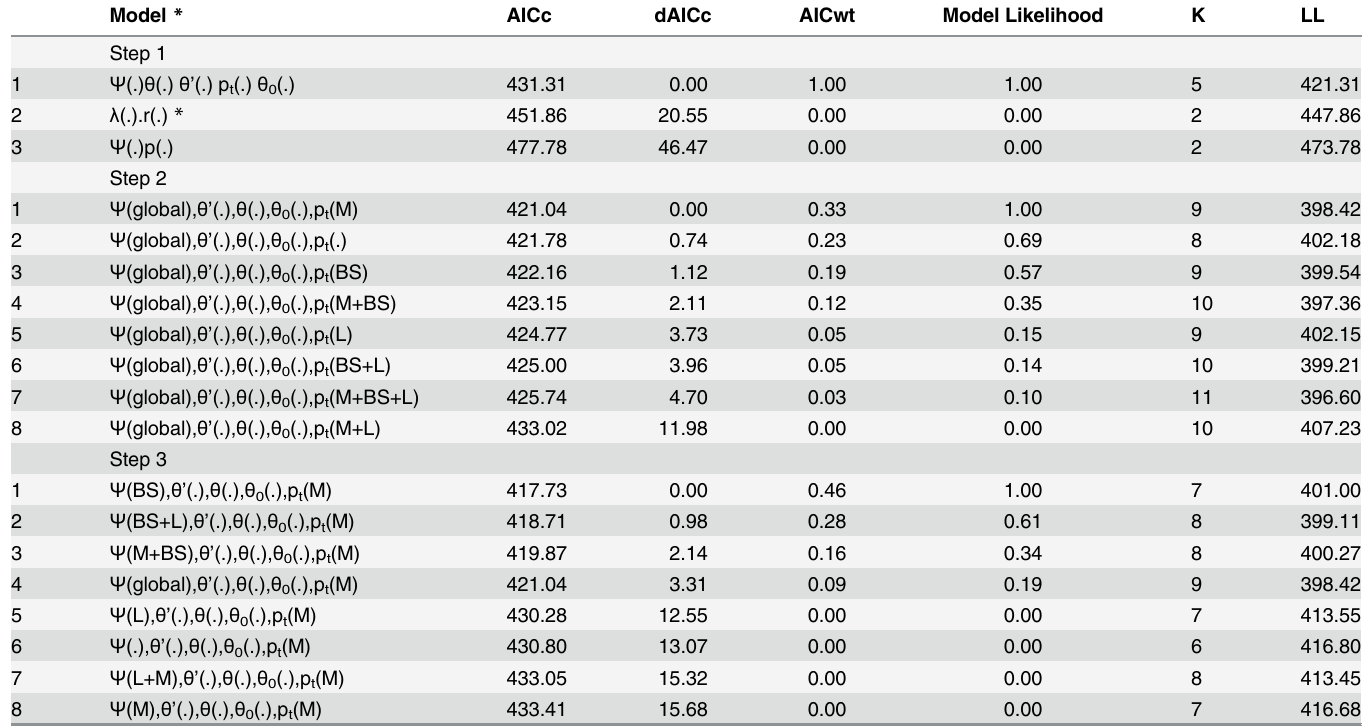
Table 1. Summary of model selection results; role of covariates in determining snow leopard detection and site-use probability on 500 m long spa- tial replicates used in the field survey conducted in Qilianshan National Nature Reserve, 2014. Number of sites = 49. Model *